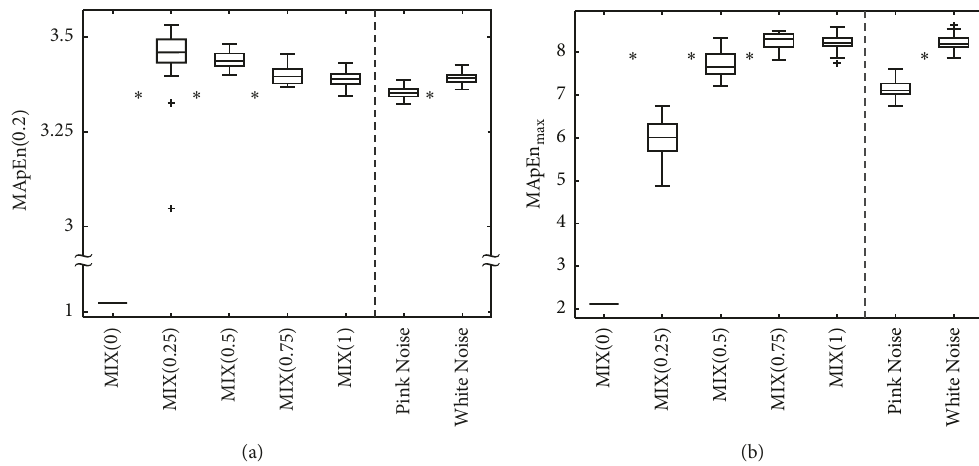
Figure 2: (a) MApEn(0.2) and (b) 𝑀𝐴𝑝𝐸𝑛 𝑚𝑎𝑥 evaluated over MIX( P ) processes with varying stochasticlevels as well as white and pink noise. ( ∗ ) indicates statistically significant differences by Mann-Whitney U test ( p -values < 0.05) when comparing MIX( P ) processes or pink versus white noise time series. Data are shown as median and interquartile range over 30